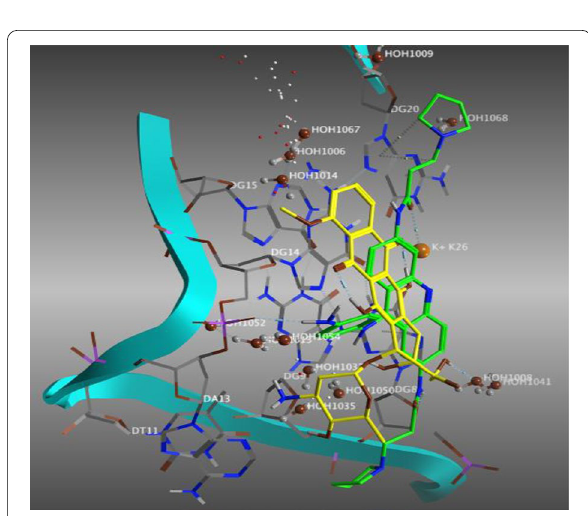
Fig. 18 3D depiction of superimposed structures of compound 82 (green) with Epirubicin